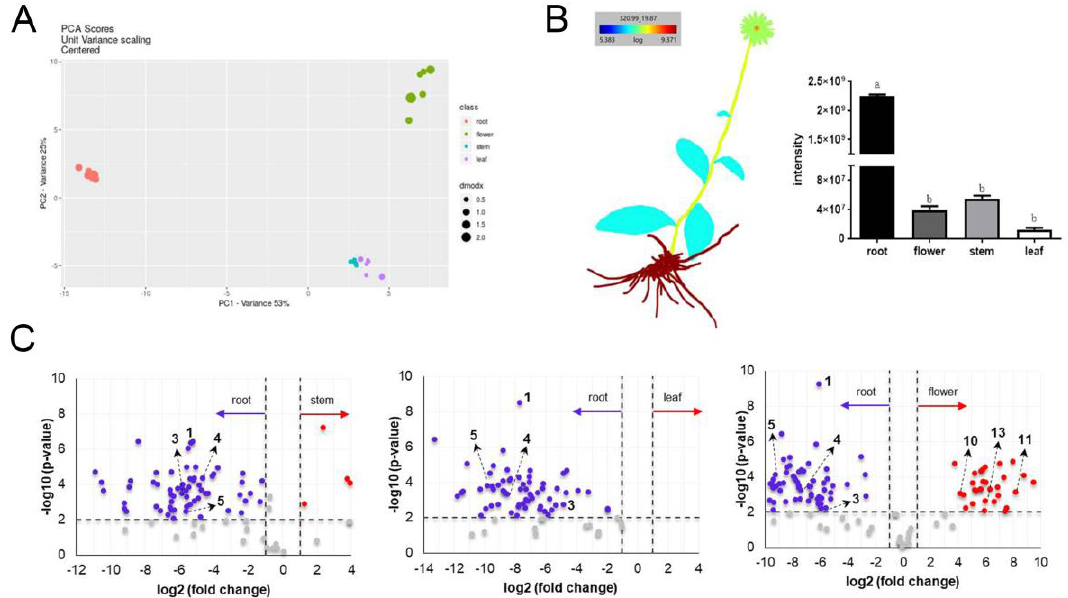
Figure 2. Multivariate analyses and visualization of metabolites from IEs. ( A ) PCA (Principal Component Analysis) plot of IEs based on parent ion intensity. ( B ) ‘ili visualization of the significant feature (compound 1 , m / z 320.9909) intensity at the logarithmic scale ( p < 0.05 between root and other parts, p = 0.931 between flower and stem, p = 726 between flower and leaf, p = 0.409 between stem and leaf). ( C ) Volcano plots for significant metabolite markers comparing between root with stem, leaf, and flower of I. nervosa Wall. (fold change > 2, p < 0.01).